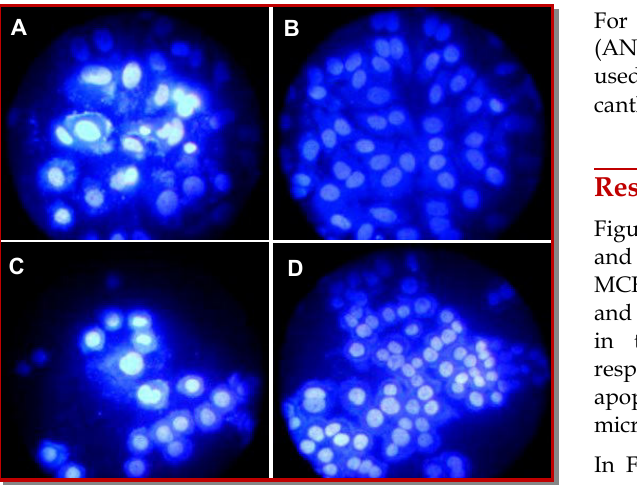
Figure 1: Cytotoxicity of the Acroptilon repens methanol extract in MCF-7 (A) and MDA-MB-468 (B) using MTT